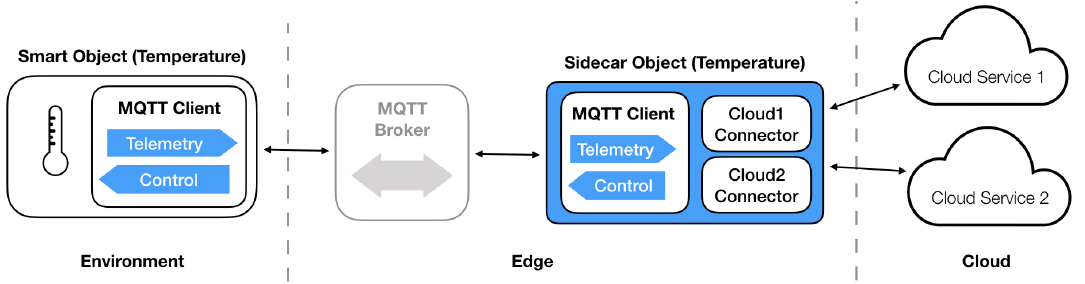
Figure 1. Application scenario involving a smart objects with enhanced capabilities through the activation of a sidecar objects for data synchronization with the